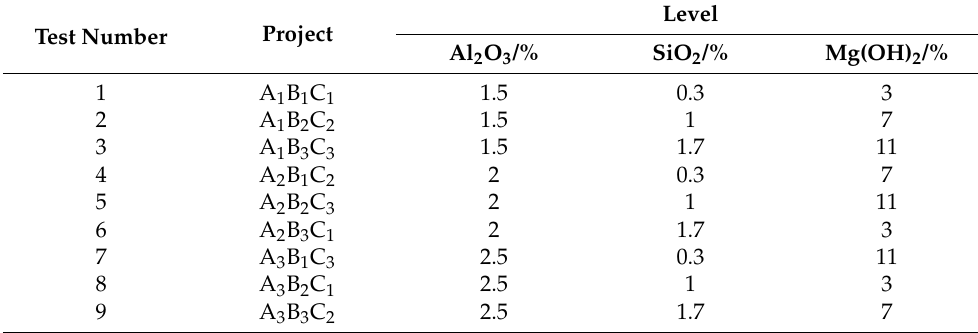
Table 2. Specific experimental design schemes in the orthogonal